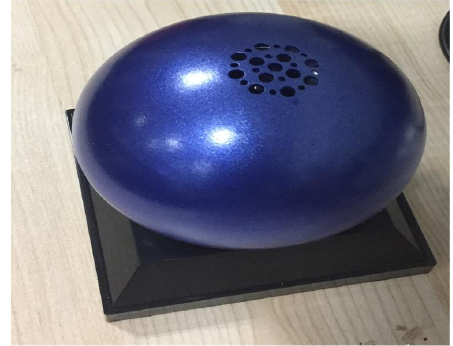
Figure 1. Free-swimming device.